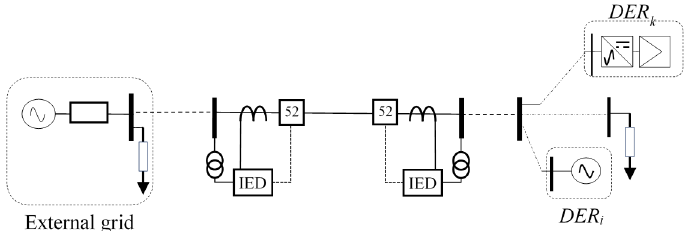
Figure 1. Intelligent electronic devices (IEDs) installed at each end point of the line section without a communication link. DER: Distributed energy communication link. DER: Distributed energy resources.